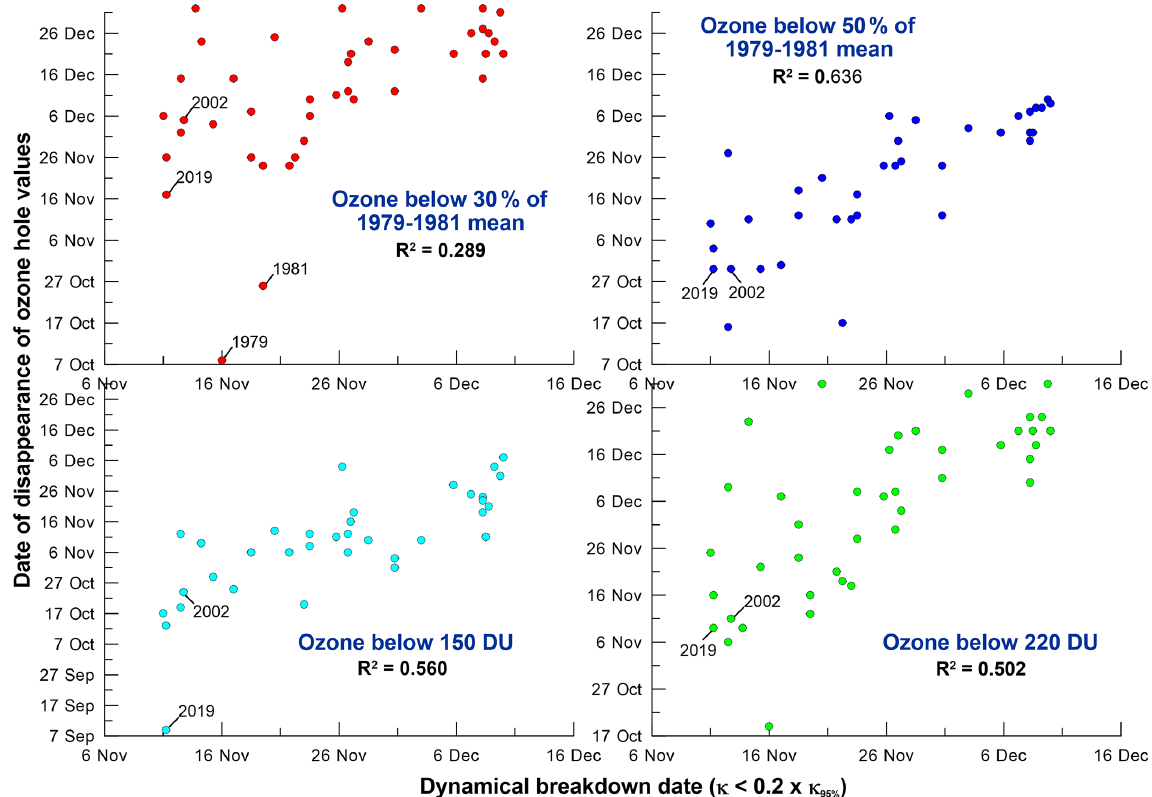
Figure 5. The annual dates of disappearance of ozone hole type values for all four threshold criteria plotted against the annual date of the breakdown of the dynamical vortex. R 2 values for linear fits to the data plotted in each panel are also shown.